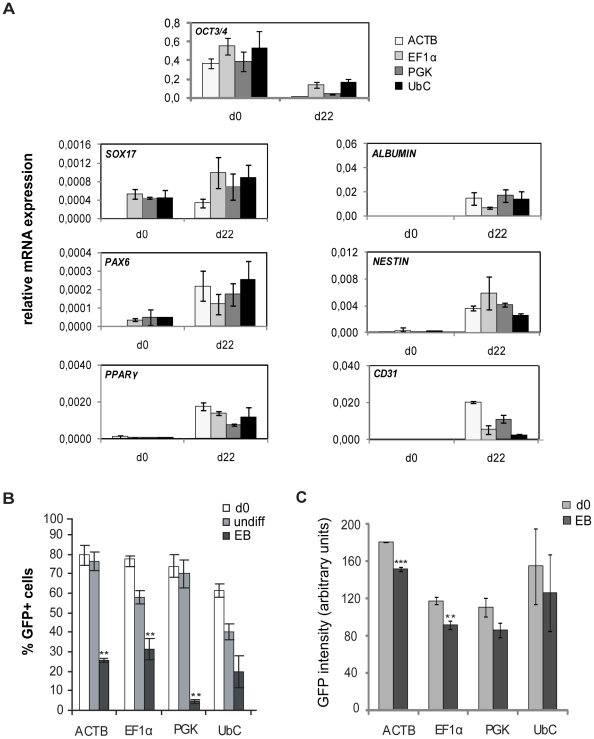
Promoter activity during differentiation of hESCs.
A. Gene expression analysis of undifferentiated ACTB-, CMV-, EF1α-, PGK- or UbC-eGFP transduced hESCs and after EB differentiation, plotted as relative to reference gene GAPDH. SOX17, ALBUMIN, PAX6, NESTIN, PPARγ and, CD31 were used as marker genes for endodermal, ectodermal and mesodermal cell lineages and OCT3/4 as pluripotency marker. Results in A–C are plotted as mean of three independent experiments and error bars indicate ± s.d, B. hESC line SA121 was differentiated as embryonic bodies for 22 days and promoter activities in ACTB-, CMV-, EF1α-, PGK- or UbC-eGFP transduced cells were measured by FACS analysis as % eGFP+ cells. In parallel, % eGFP+ cells were measured on ACTB-, CMV-, EF1α-, PGK- or UbC-eGFP transduced cells that were maintained in their undifferentiated state for 22 days. Statistical analysis of EB day 22 as compared to undifferentiated day 22 (**p≤0.0039 students t'test). C. Average level of intensity of eGFP fluorescent signal of the eGFP+ population, detected by FACS analysis at start of differentiation, day 0 and after 22 days, measured as average mean fluorescence intensity. Statistical analysis of EB d22 as compared to undifferentiated cells day 0 (**p<0.001,***p<0.0001 students t'test).